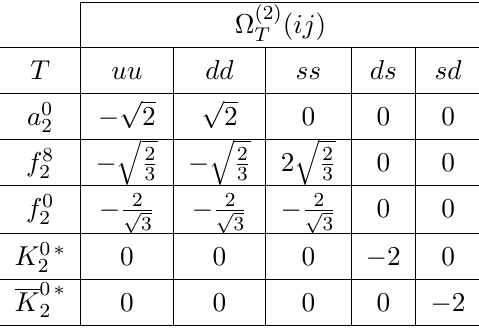
Table 13 . Factor Ω (2)